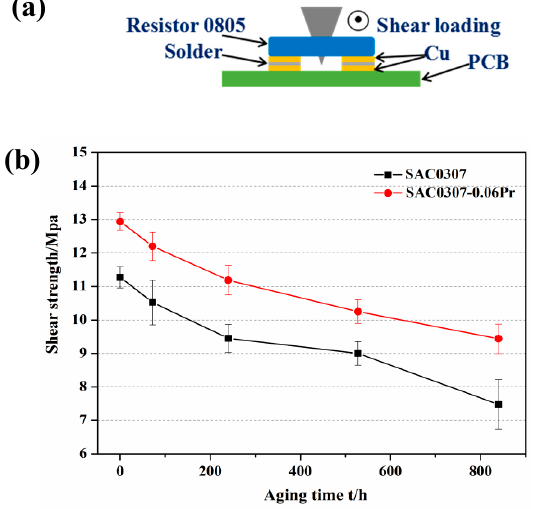
Figure 7. ( a ) Illustration of shearing process; ( b ) Changes in shear strength at Sn-0.3Ag-0.7Cu solder/Cu and Sn-0.3Ag-0.7Cu-0.05Pr/Cu solder aged for different hrs.